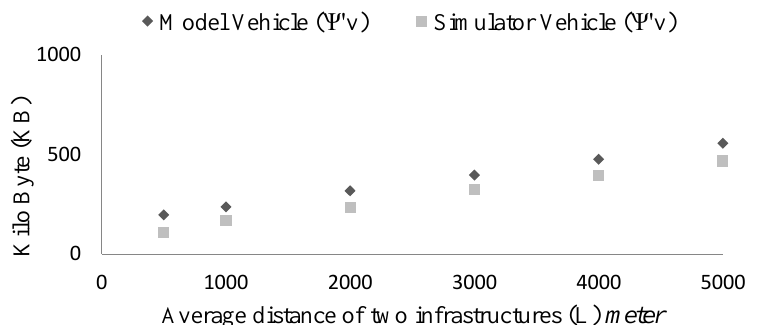
Figure 16. Effect of roadside infrastructure density ( L ) on the storage requirements for the simulation and the